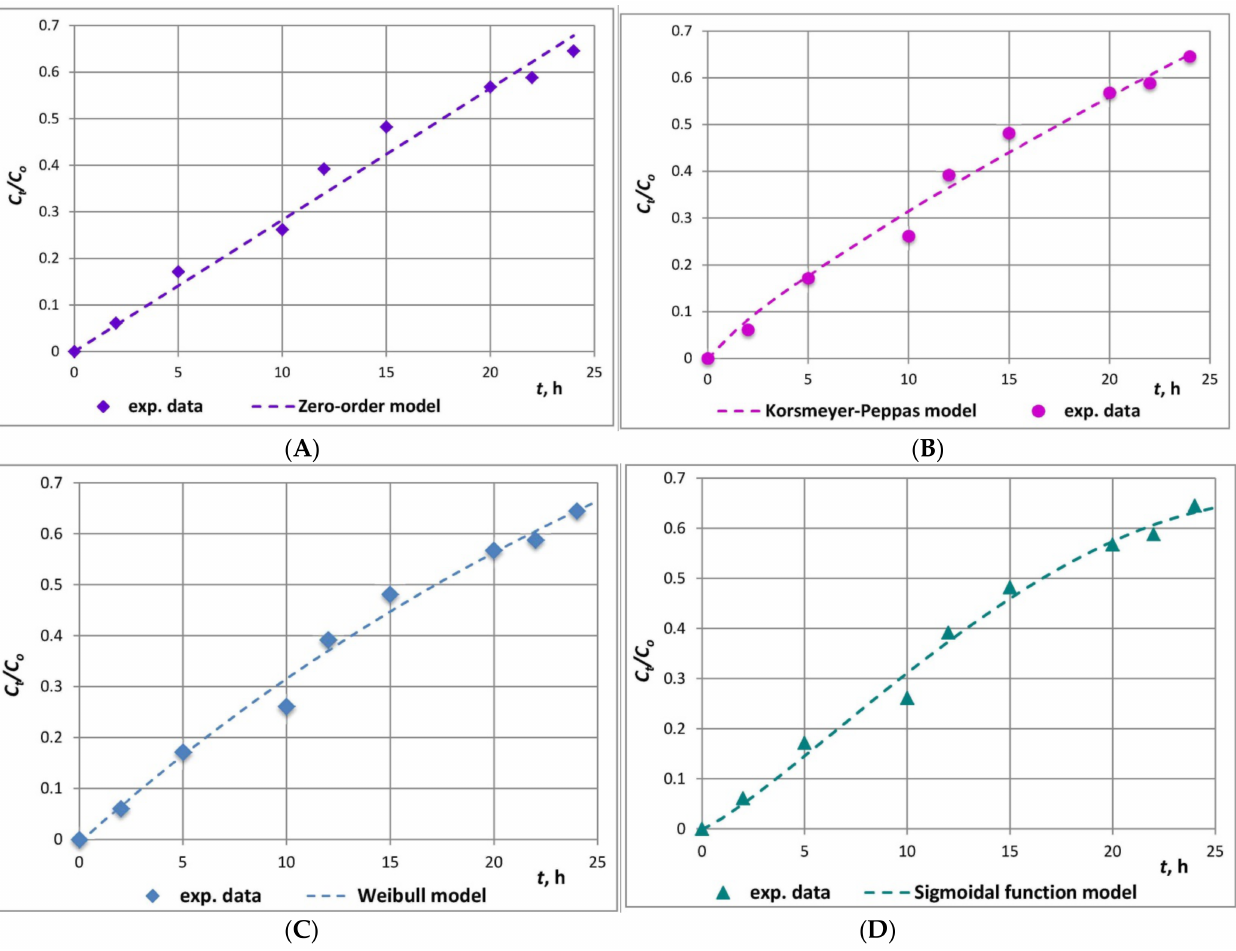
Figure 5. Experimental and ( A ) zero-order, ( B ) Korsmeyer-Peppas, ( C ) Weibull ( n = 1), ( D ) sigmoidal function model in vitro release kinetics curves of